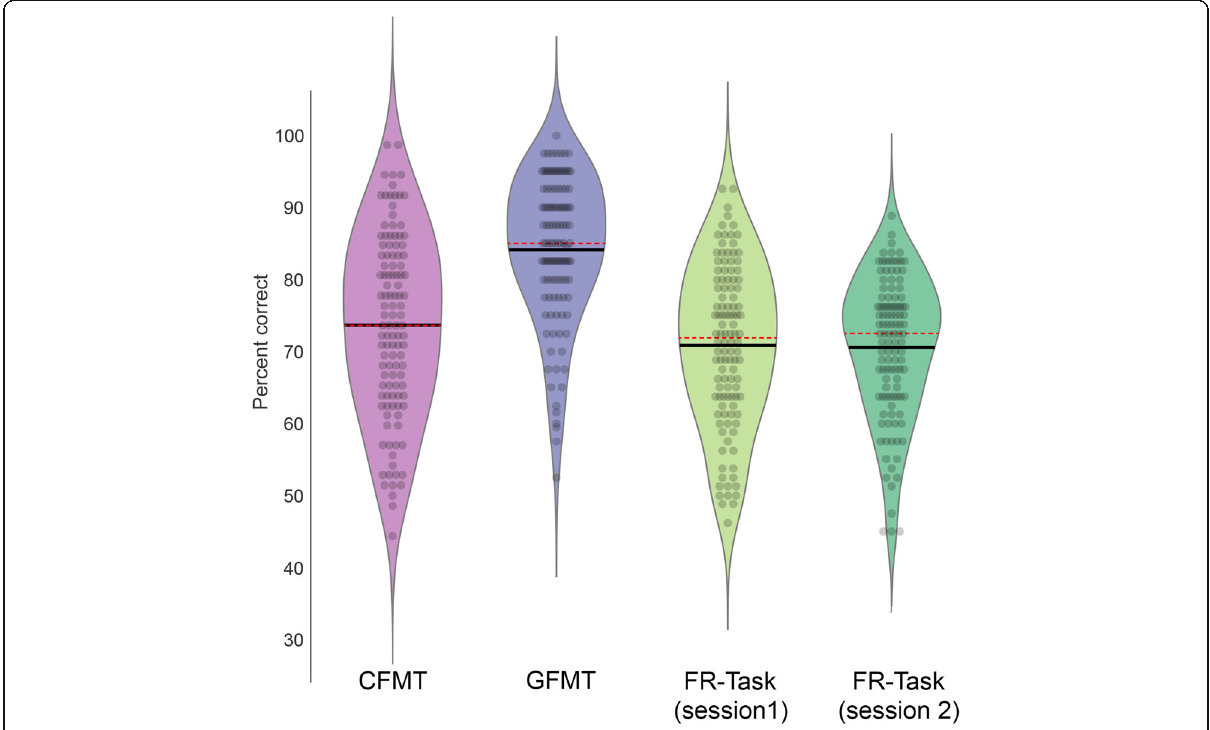
Fig. 2 Accuracy distributions for face identification tests. Means are shown in the solid black lines and medians in the red dashed lines. The width of each ‘ violin ’ represents the expected probability density of that score based on the data and assuming a Gaussian distribution. Individual data points are shown as grey dots. See main text for details. CFMT Cambridge face memory test, FR-Task Face Recognition Candidate List Review Task, GFMT Glasgow face matching